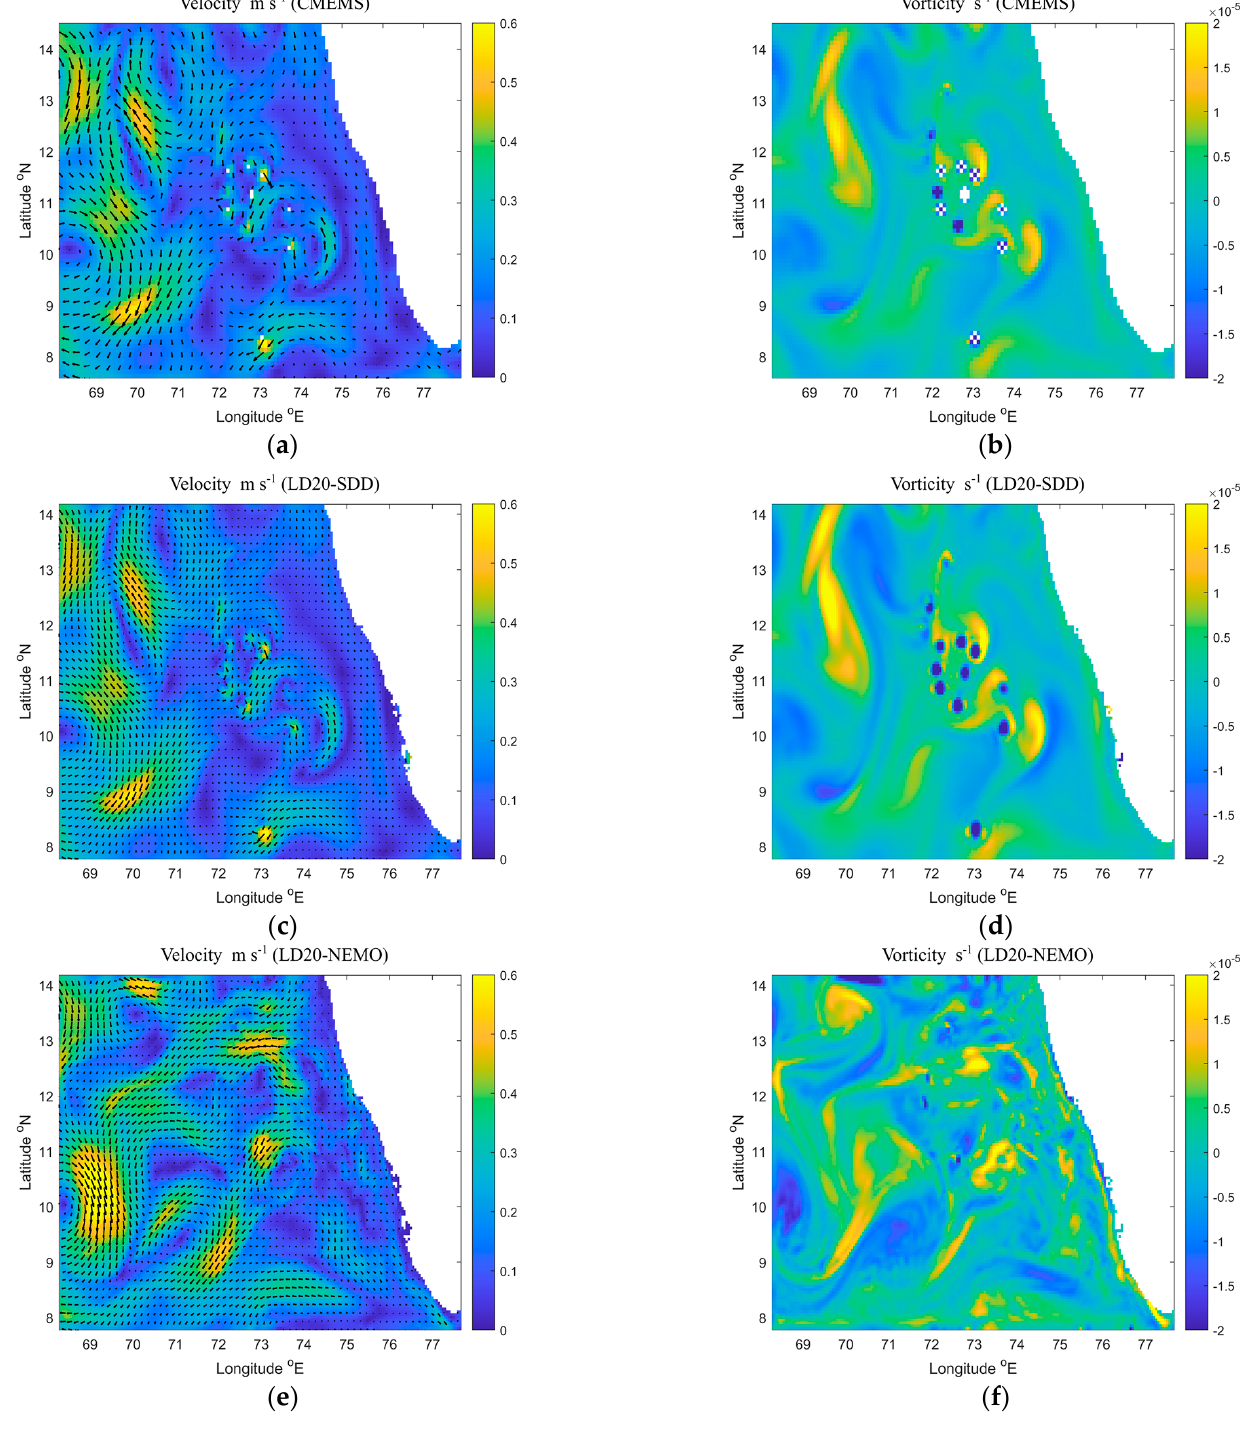
Figure 7. Velocity (left panels) and vorticity (right panels) computed by CMEMS ( a , b ), LD20-SDD ( c , d ), and LD20-NEMO ( e , f ), models on 15 May 2015.